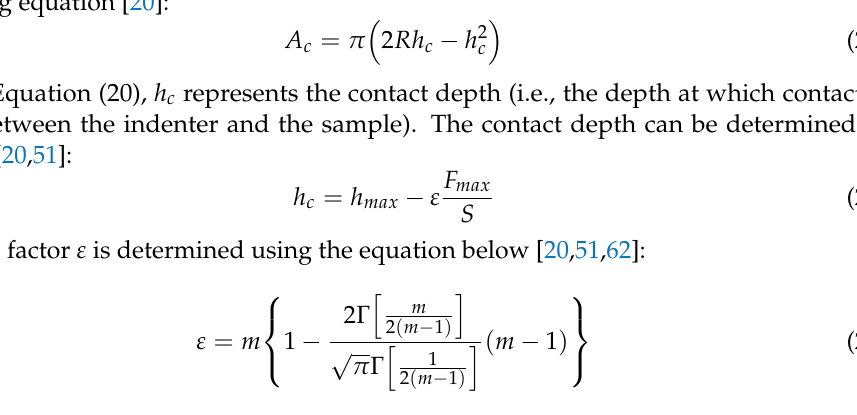
Figure 6. The elastic – plastic contact. The unloading force – indentation data can be fitted to Equation (18). The final depth (depth at which the deformation is permanent) is calculated as a fitting parameter. A simple method for fitting the unloading data can be found in [62]. The slope of fitted curve at the maximum indentation depth equals to the contact stiffness S (Equation (19)).